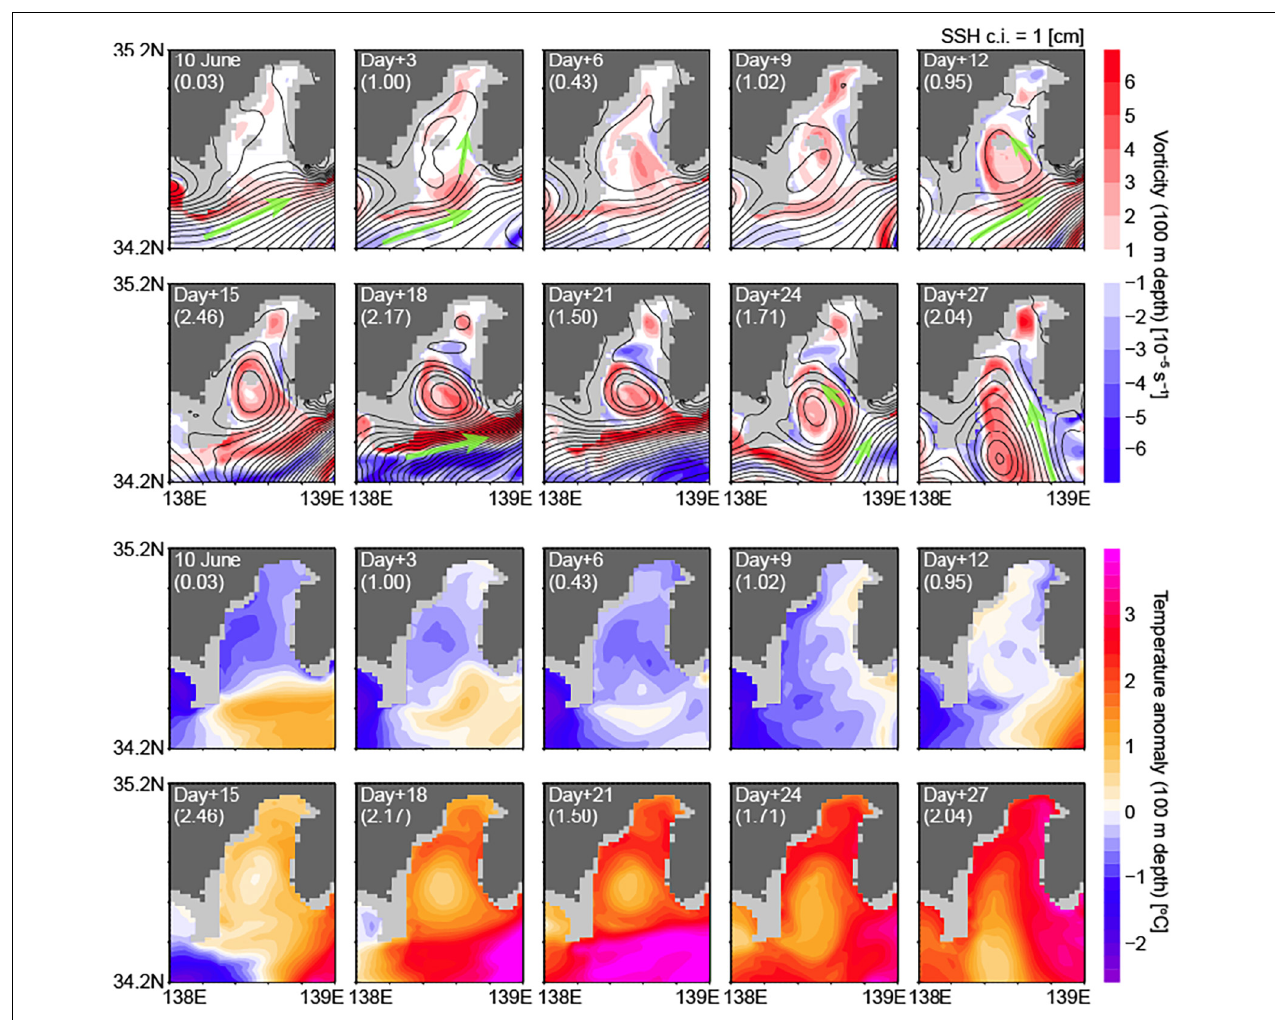
FIGURE 8 | Distributions of SSHs (contours with 1 cm intervals) and relative vorticities at 100 m depth (shading) (upper 2 rows) and potential temperature anomalies at 100 m depth (lower 2 rows) during a positive EOF1 event starting from 10 June 2017 ( top left ). Time series for every 3 days are plotted ( top left to top right and then bottom left to bottom right for each series). Days from 10 June and the EOF1 time coefficient are indicated in each figure. Relative vorticity was defined in this study as ζ = v x − u y , where u and v are zonal ( x -ward) and meridional ( y -ward) components of horizontal velocity, respectively. Broad flow directions are indicated by green